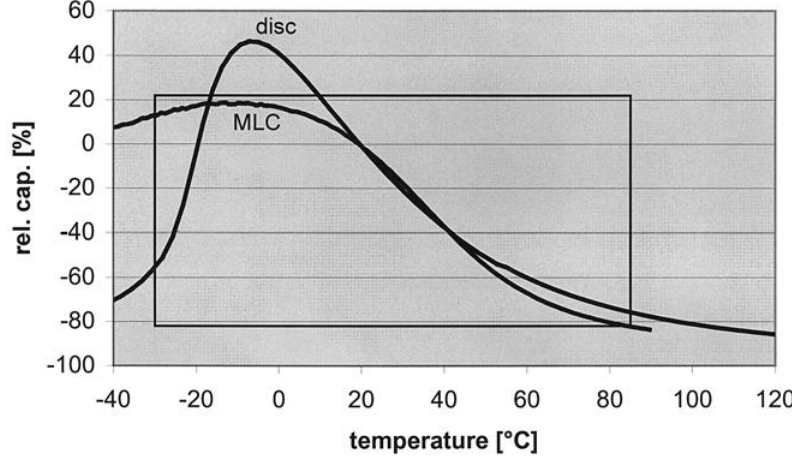
FIGURE 5 TCC of disc capacitor and